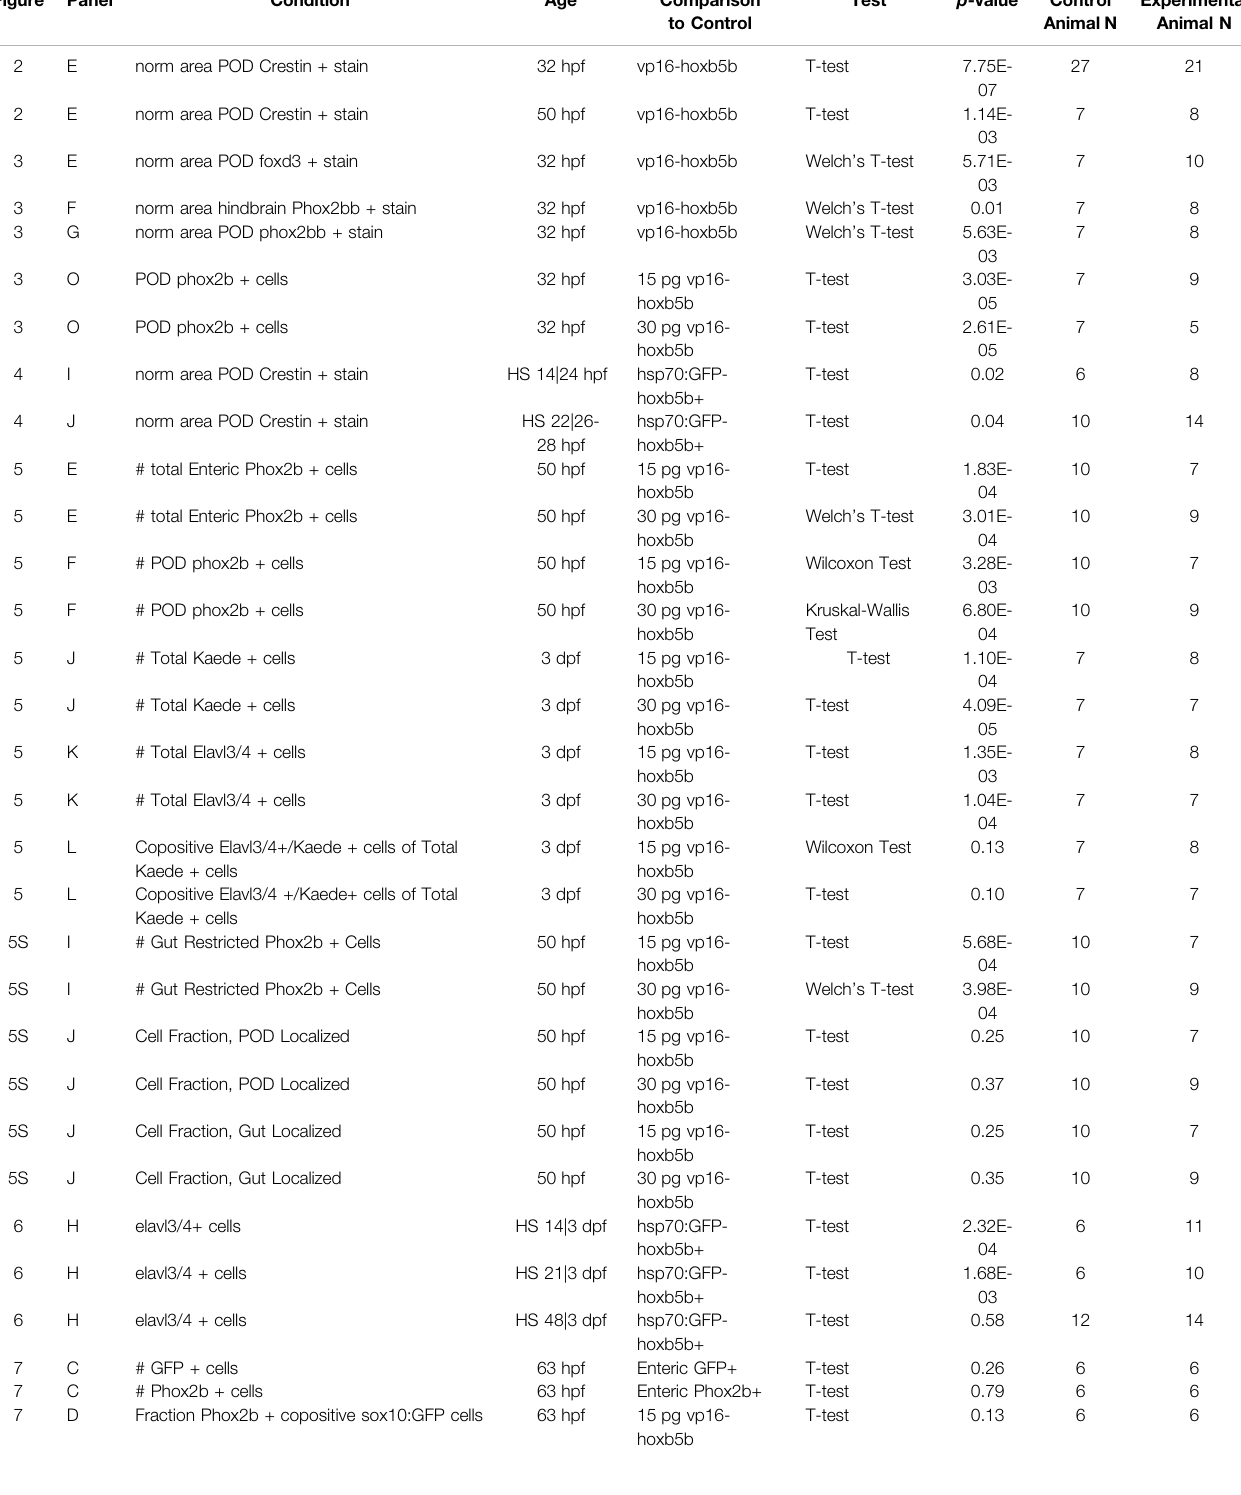
TABLE 1 | Summary of Statistical Tests. Figure